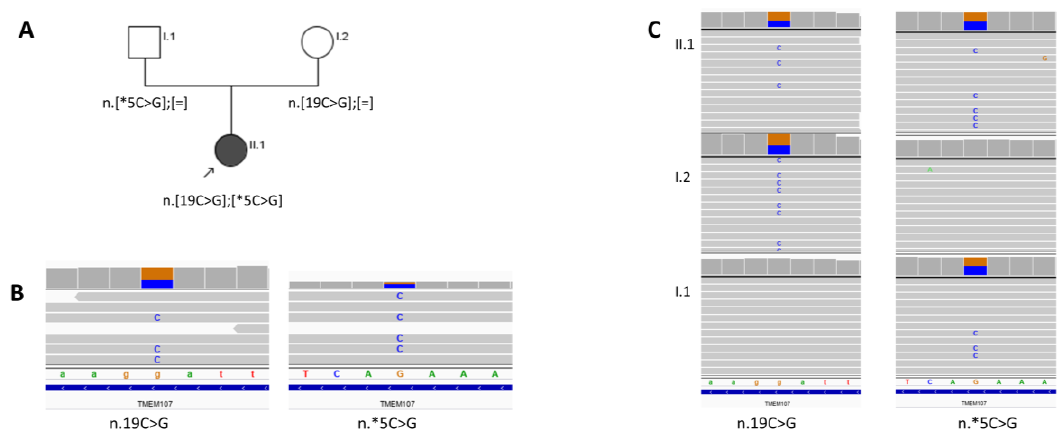
Figure 4. Pedigree of the studied family ( A ) and the results of WES and ADS for the variants in the SNORD118 gene; ( B )—WES results; ( C ) results of amplicon deep sequencing in the proband, her parents (I–proband, II–mother, III–father). The obtained coverage of the ADS for the n.19C > G position in